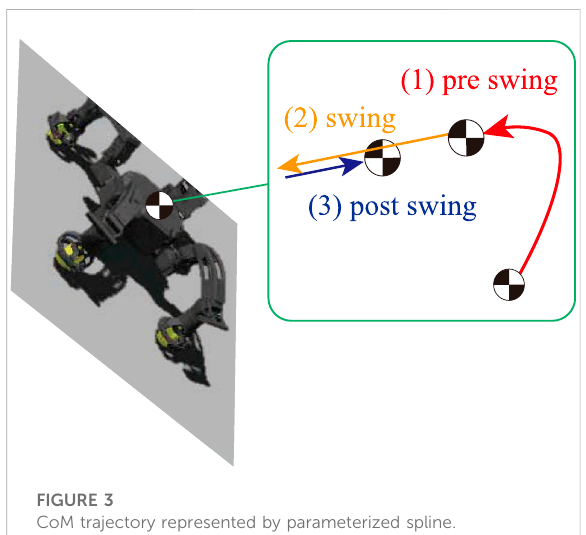
FIGURE 3 CoM trajectory represented by parameterized